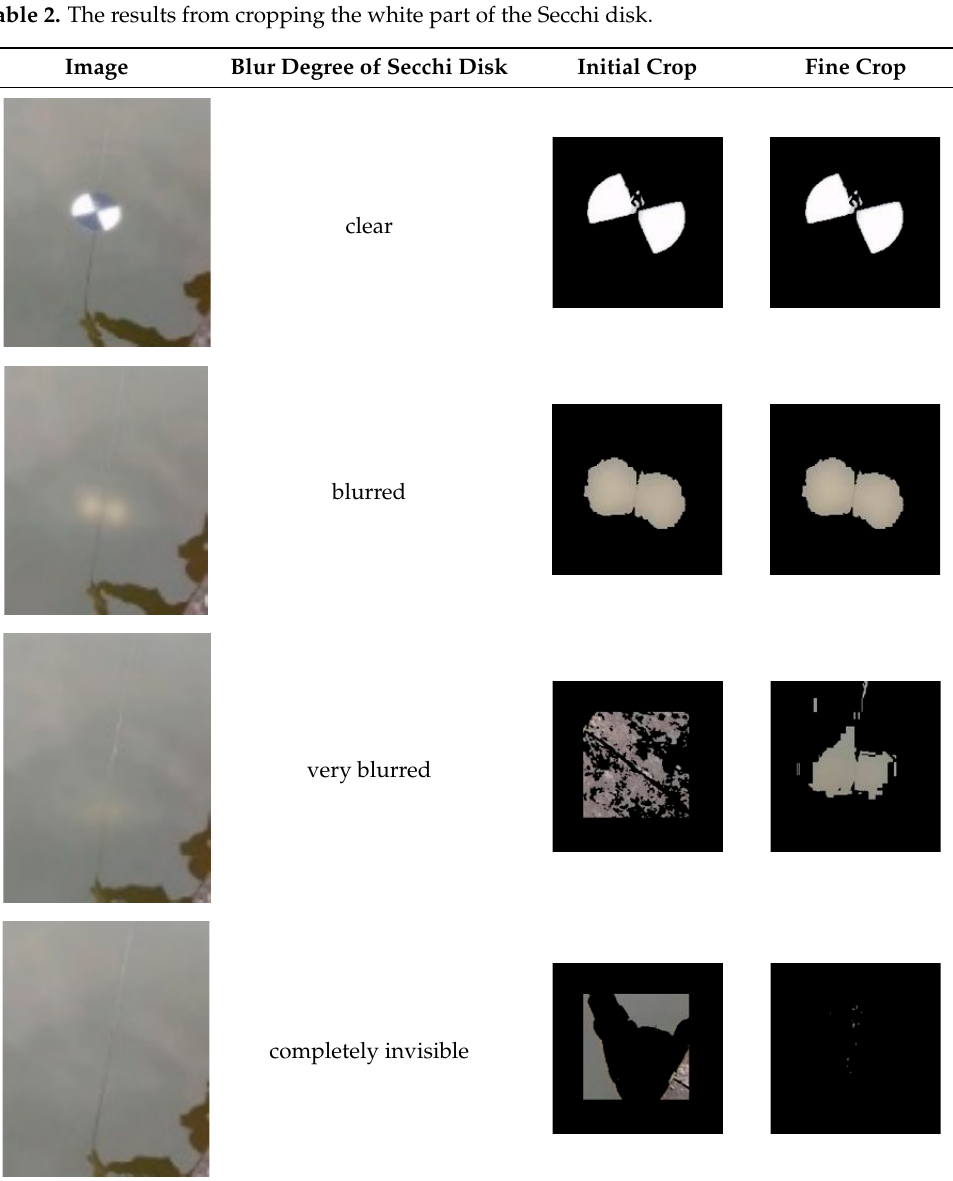
9 of 18 Figure 6. Loss and accuracy in classification network training of Secchi disk.